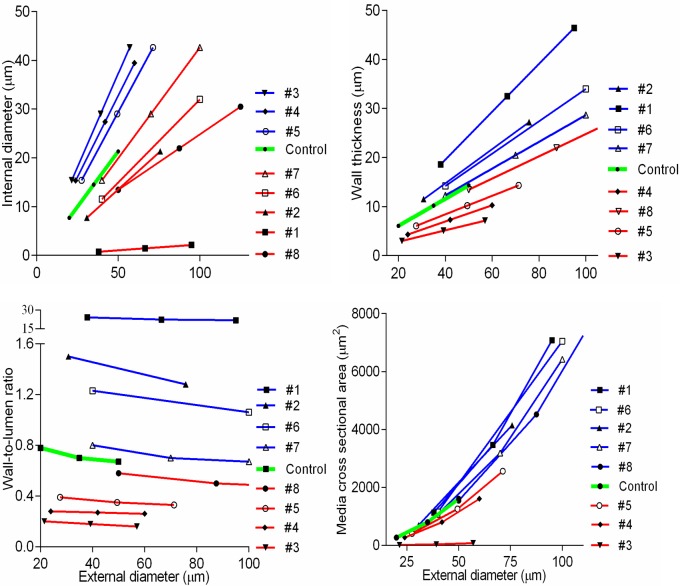
Remodeling variants are not distinguishable in two-dimensional graphs.The remodeling of renal arteries for the variants #1–8 show similar line shifts, that could distinguish only increase or decrease from control but not verify a particular pattern. Complementary graphs are in S7 Fig.